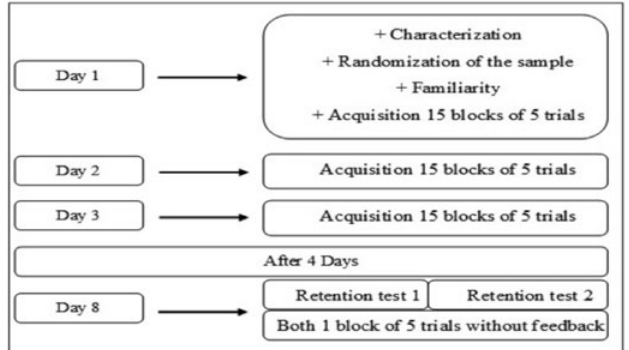
Figure 3. Representative line of the